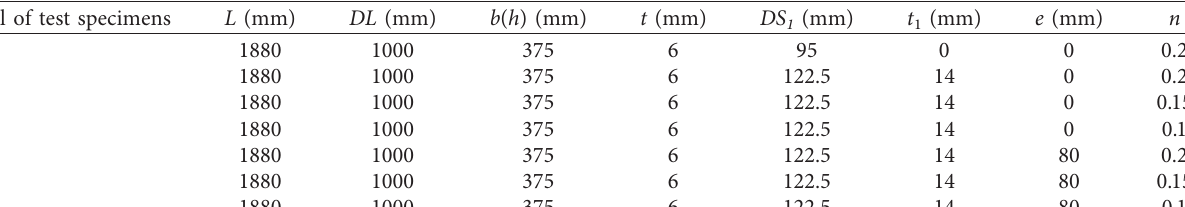
Table 1: The design parameters of pseudostatic specimens.